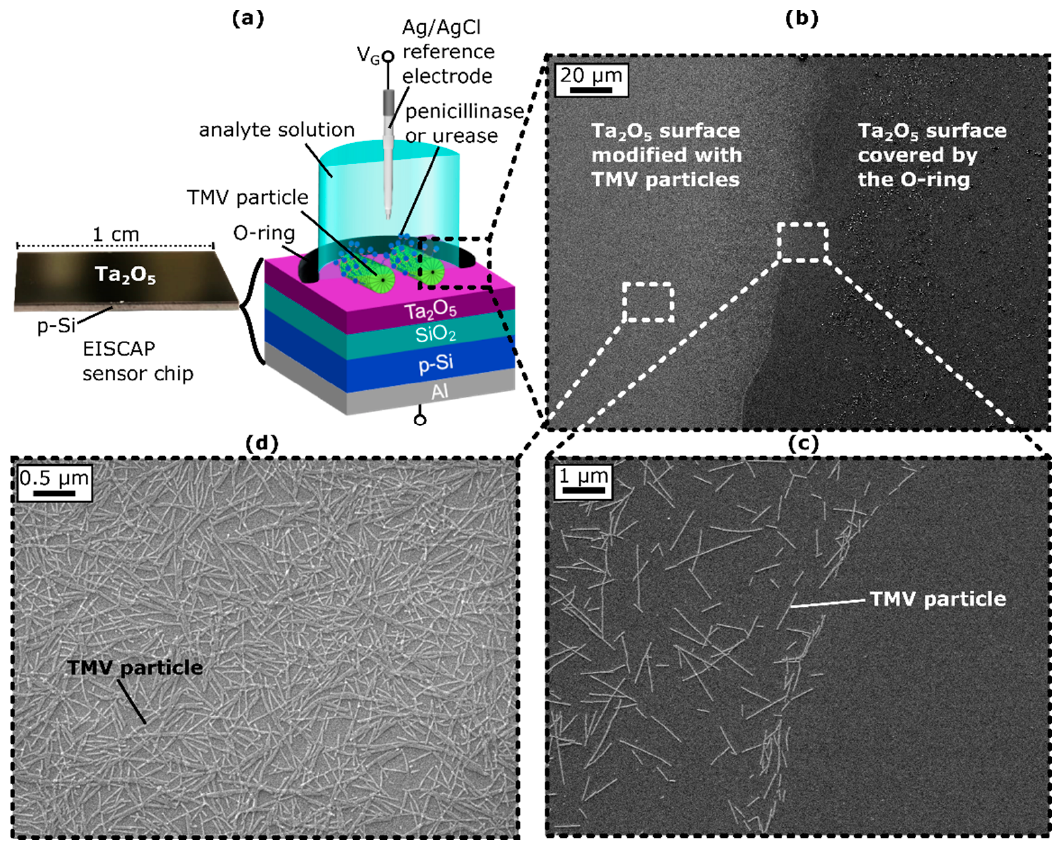
Figure 1. ( a ) Photo of the EISCAP sensor chip (left) and schematic layer structure (right) of the TMV- assisted Al/p-Si/SiO 2 /Ta 2 O 5 -EISCAP sensor modified with penicillinase and/or urease, mounted in a measurement cell and sealed by an O-ring. ( b ) Scanning electron microscopic (SEM) image of the Ta 2 O 5 -gate surface showing the distinguished areas where the Ta 2 O 5 surface is covered by the O-ring preventing TMV adsorption (right) and the area inside the O-ring, where the Ta 2 O 5 is modified with TMV particles (left). ( c ) Magnification of the border line between TMV particle-modified and bare Ta 2 O 5 surface. ( d ) Zoomed out image of the TMV particle-modified surface area. V G : gate voltage.